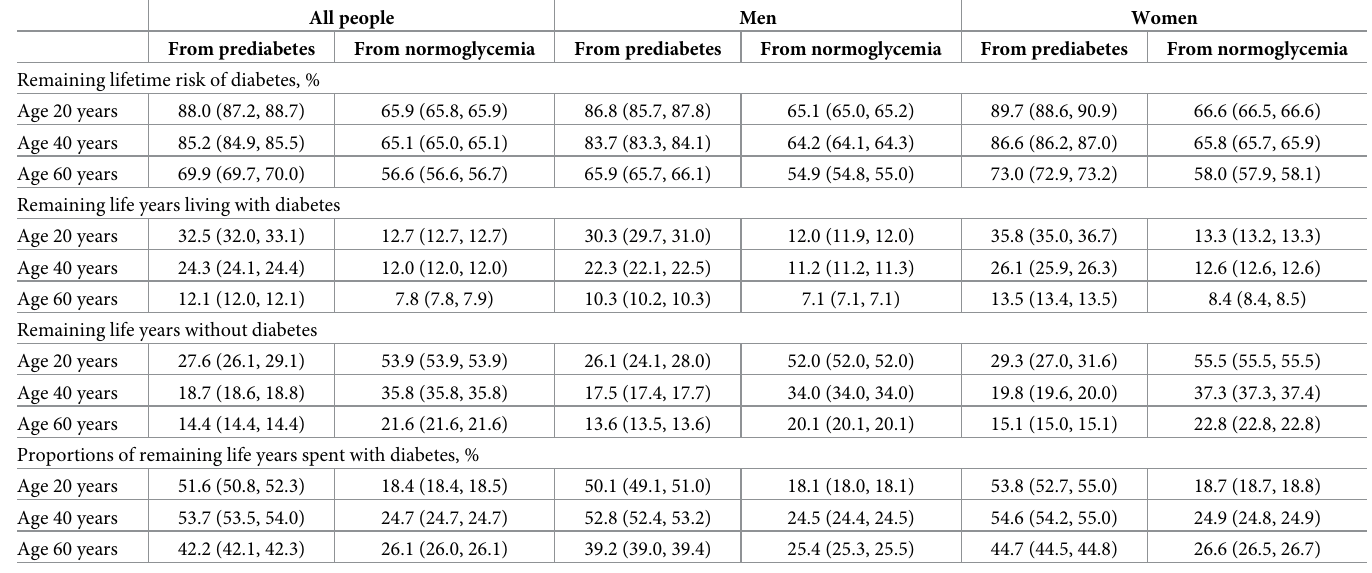
Figures in brackets represent 95% confidence